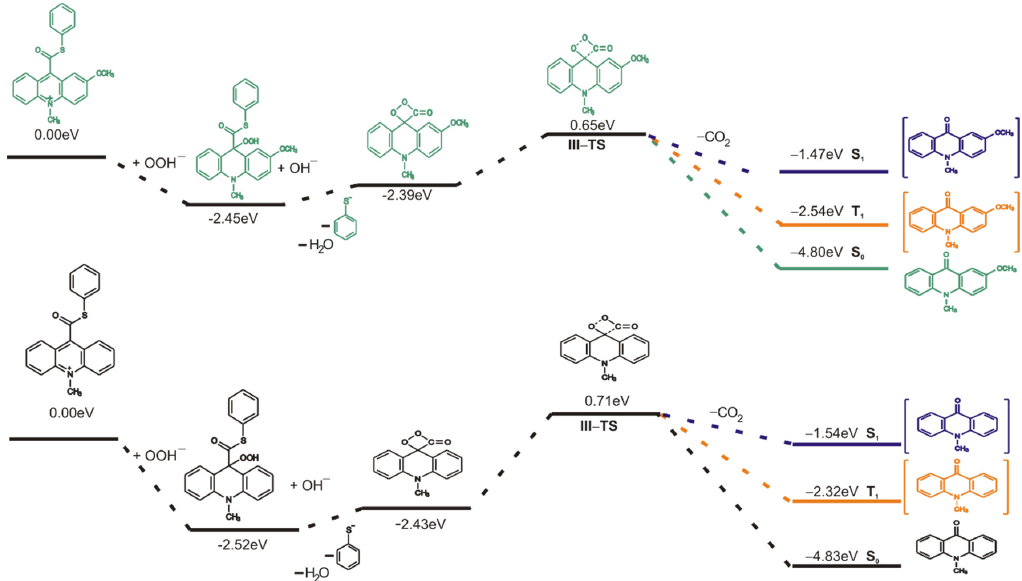
Figure 4. Energy diagram of the chemiluminescence reaction in the aqueous phase with energy of the lowest triplet (T 1 ) and singlet (S 1 ) states.